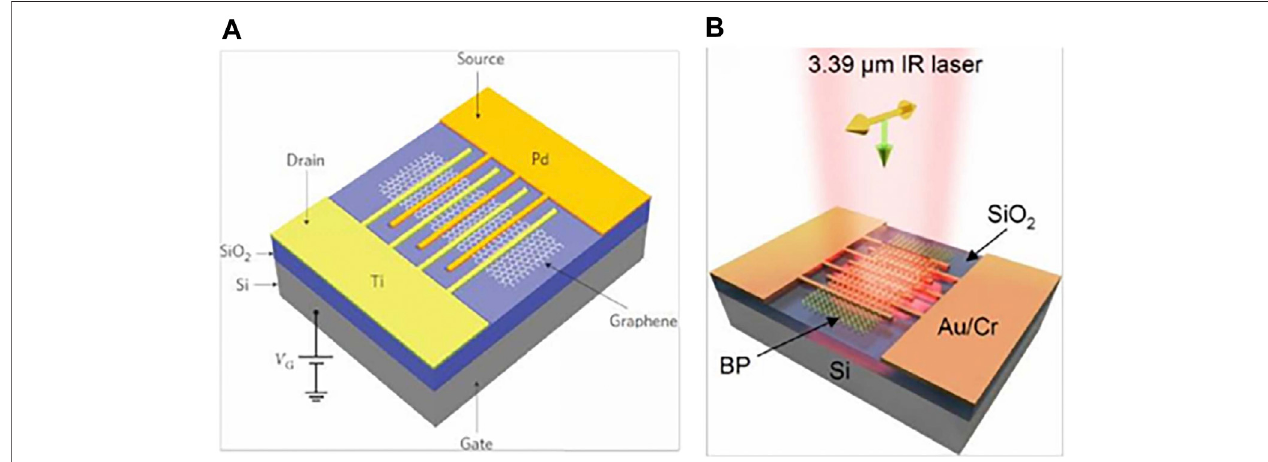
FIGURE9|(A) PhotodetectorbasedonferroelectricpolymerandMoS 2 (Wangetal.,2015b). (B) PhotodetectorbasedonferroelectricpolymerandMoTe 2 (Huang etal.,2016b). (C) Plasmonicmicrocavityintegratedgraphenephotodetector(Wangetal.,2020). (D) Cross-sectionalschematicofthegraphenephotodetectorwithsplit gates and a nano disk (Wang et al., 2020).